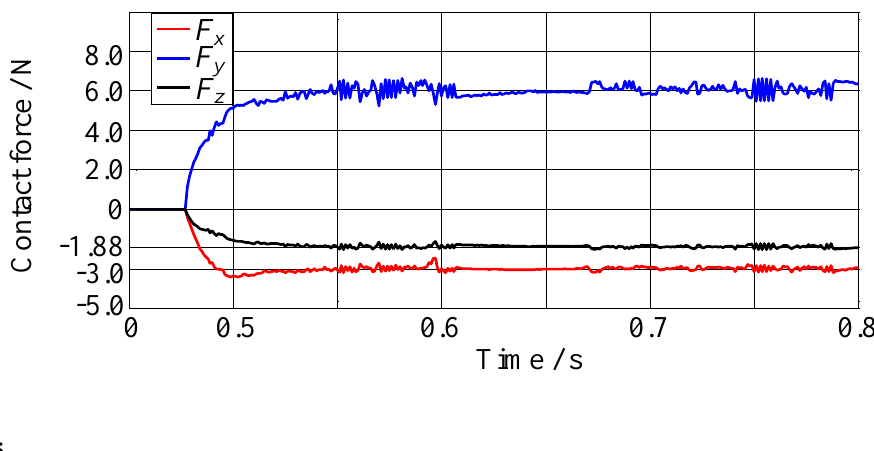
Figure 19. The force tracking results while the environment is